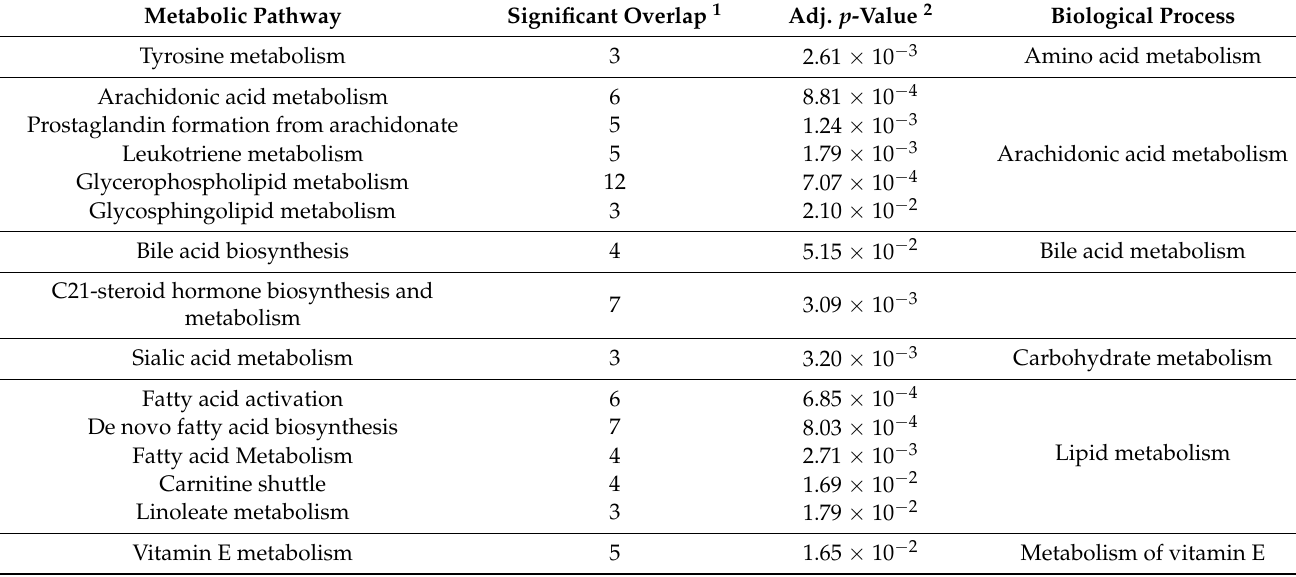
Table 2. The enriched metabolic pathways associated with MAFLD